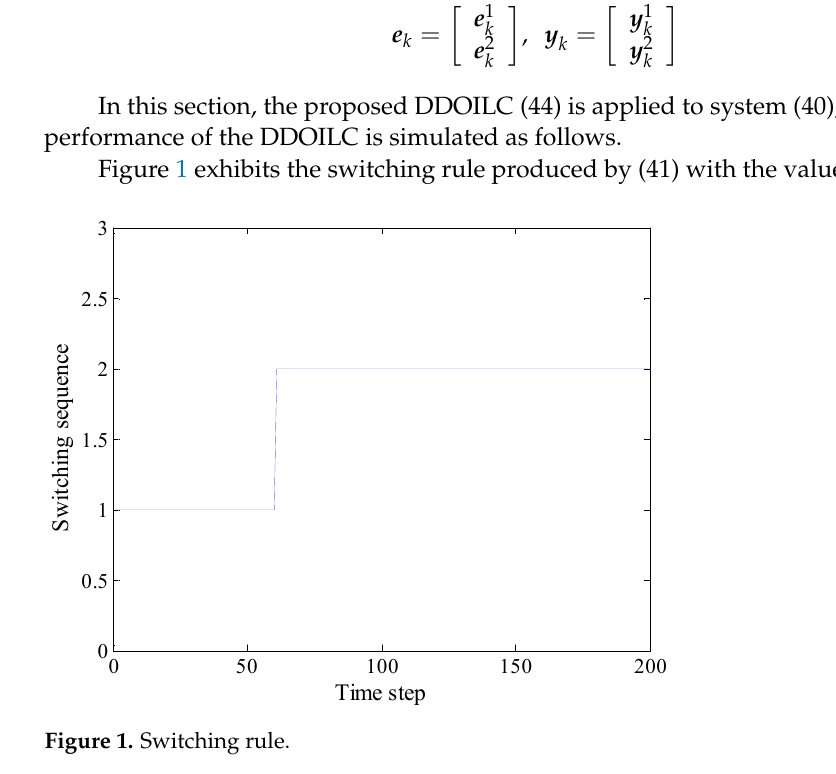
T ] T = [ g 1 , g 2 from the estimated Markov vector g k k k (cid:13) (cid:13) (cid:13) ≤ (cid:107) g − g k (cid:107) . It is also shown (cid:13) g − g k + 1